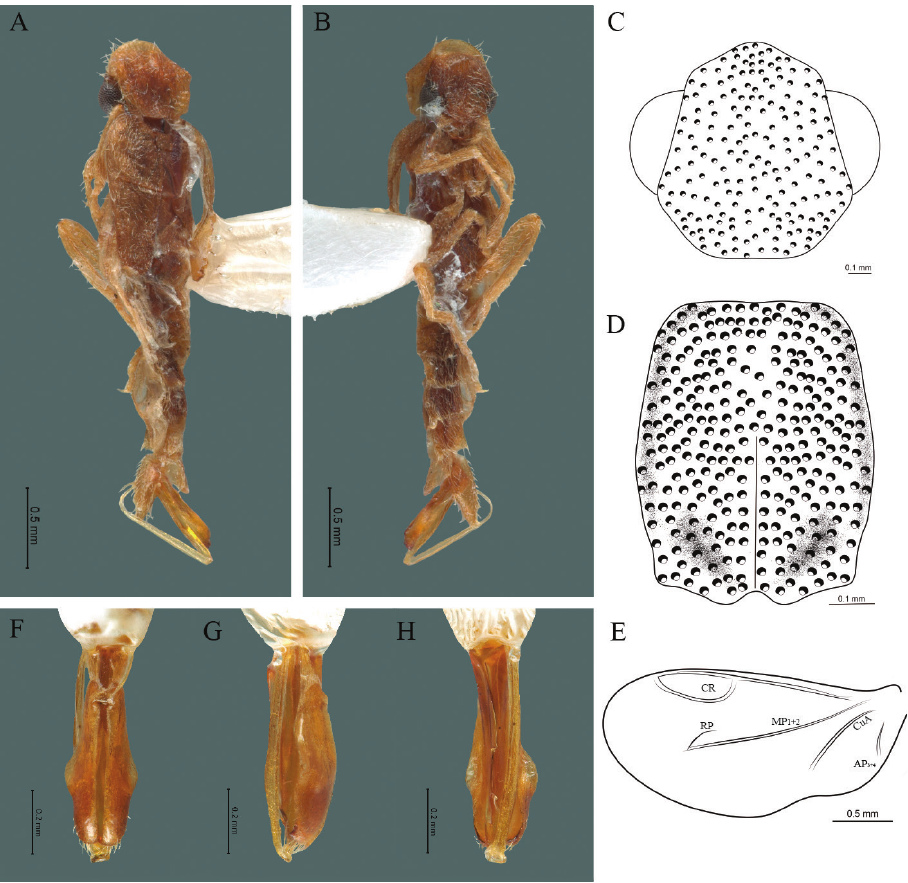
Figure 4. Cenophengus baios Zaragoza-Caballero, 2003, male. Habitus: A dorsal B ventral C head dorsal D pronotum dorsal E hind wing. Wing venation: CR = Radial Cell; RP = Posterior Radial vein; MP1+2 = Posterior Median vein; CuA = Cubital vein; AP = Posterior Anal vein. Aedeagus: F dorsal view G lateral view H ventral